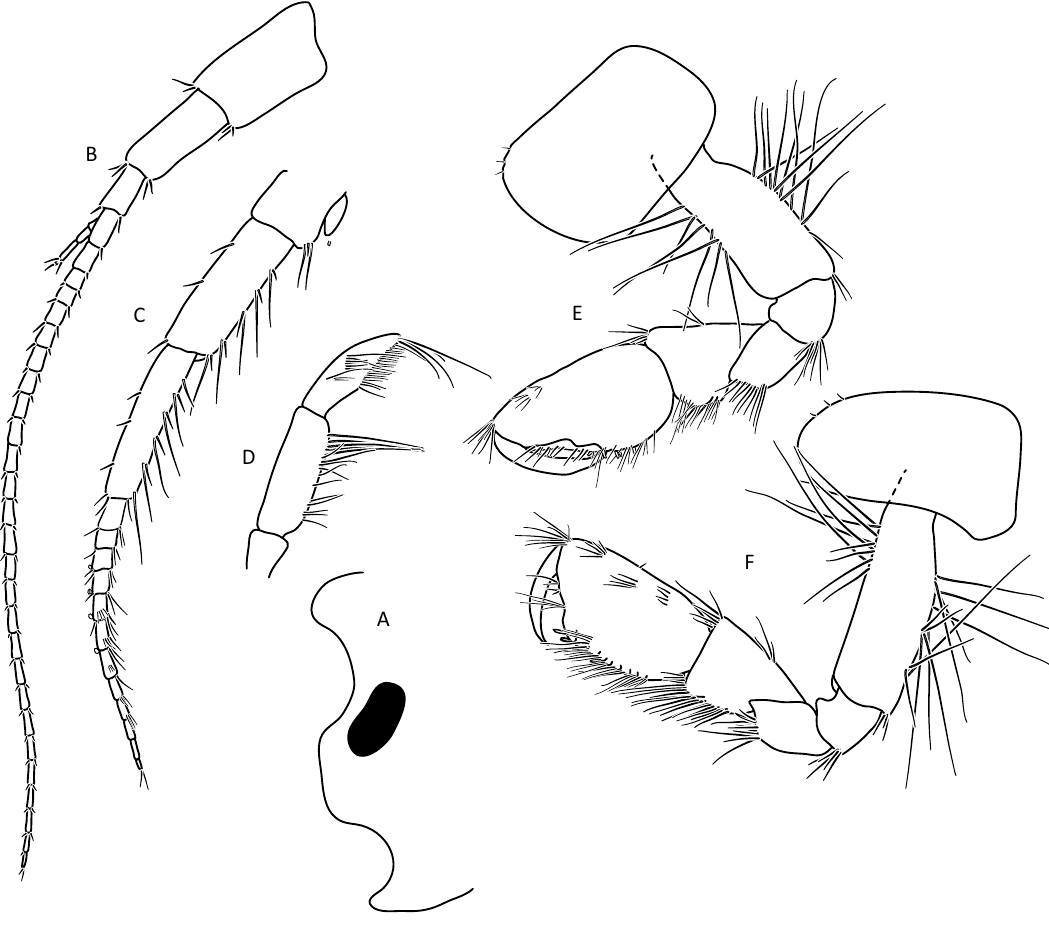
Figure 5. Gammarus stasiuki sp. nov., male—12 mm. ( a ) left side of head, ( b ) antenna 1, ( c ) antenna 2, ( d ) mandibular palp, ( e ) gnathopod 1, ( f ) gnathopod